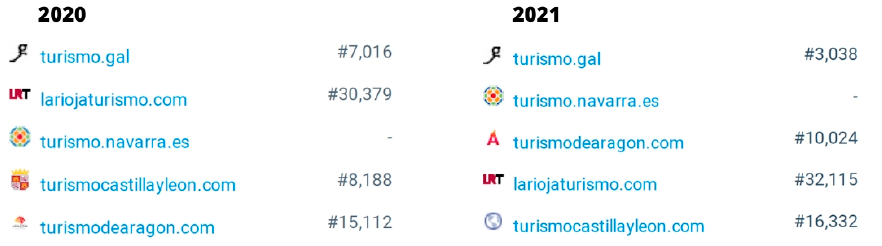
Figure 3. National ranking of official Spanish websites, 2020–2021.